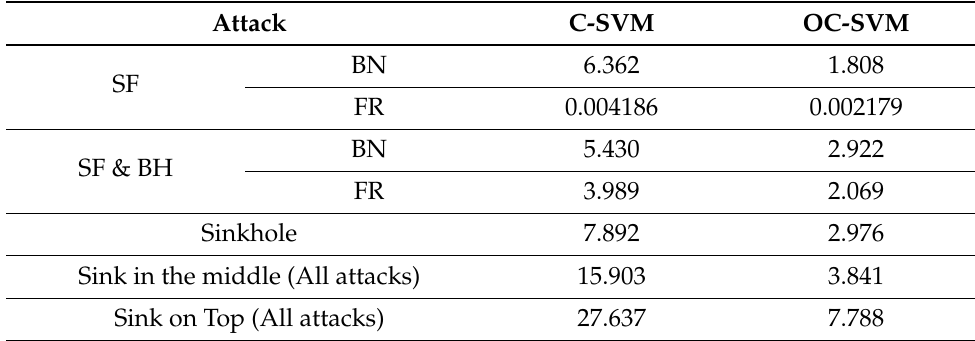
Table 6. SVM evaluation classification time (in